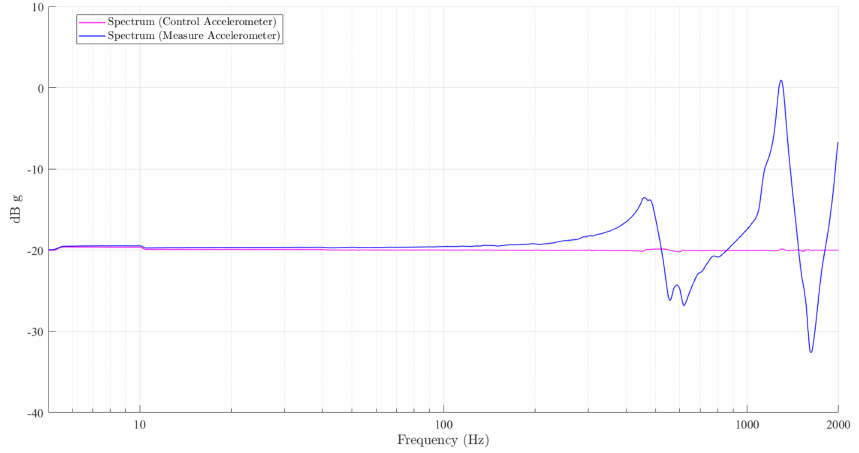
Figure 18. Natural frequencies of the system.